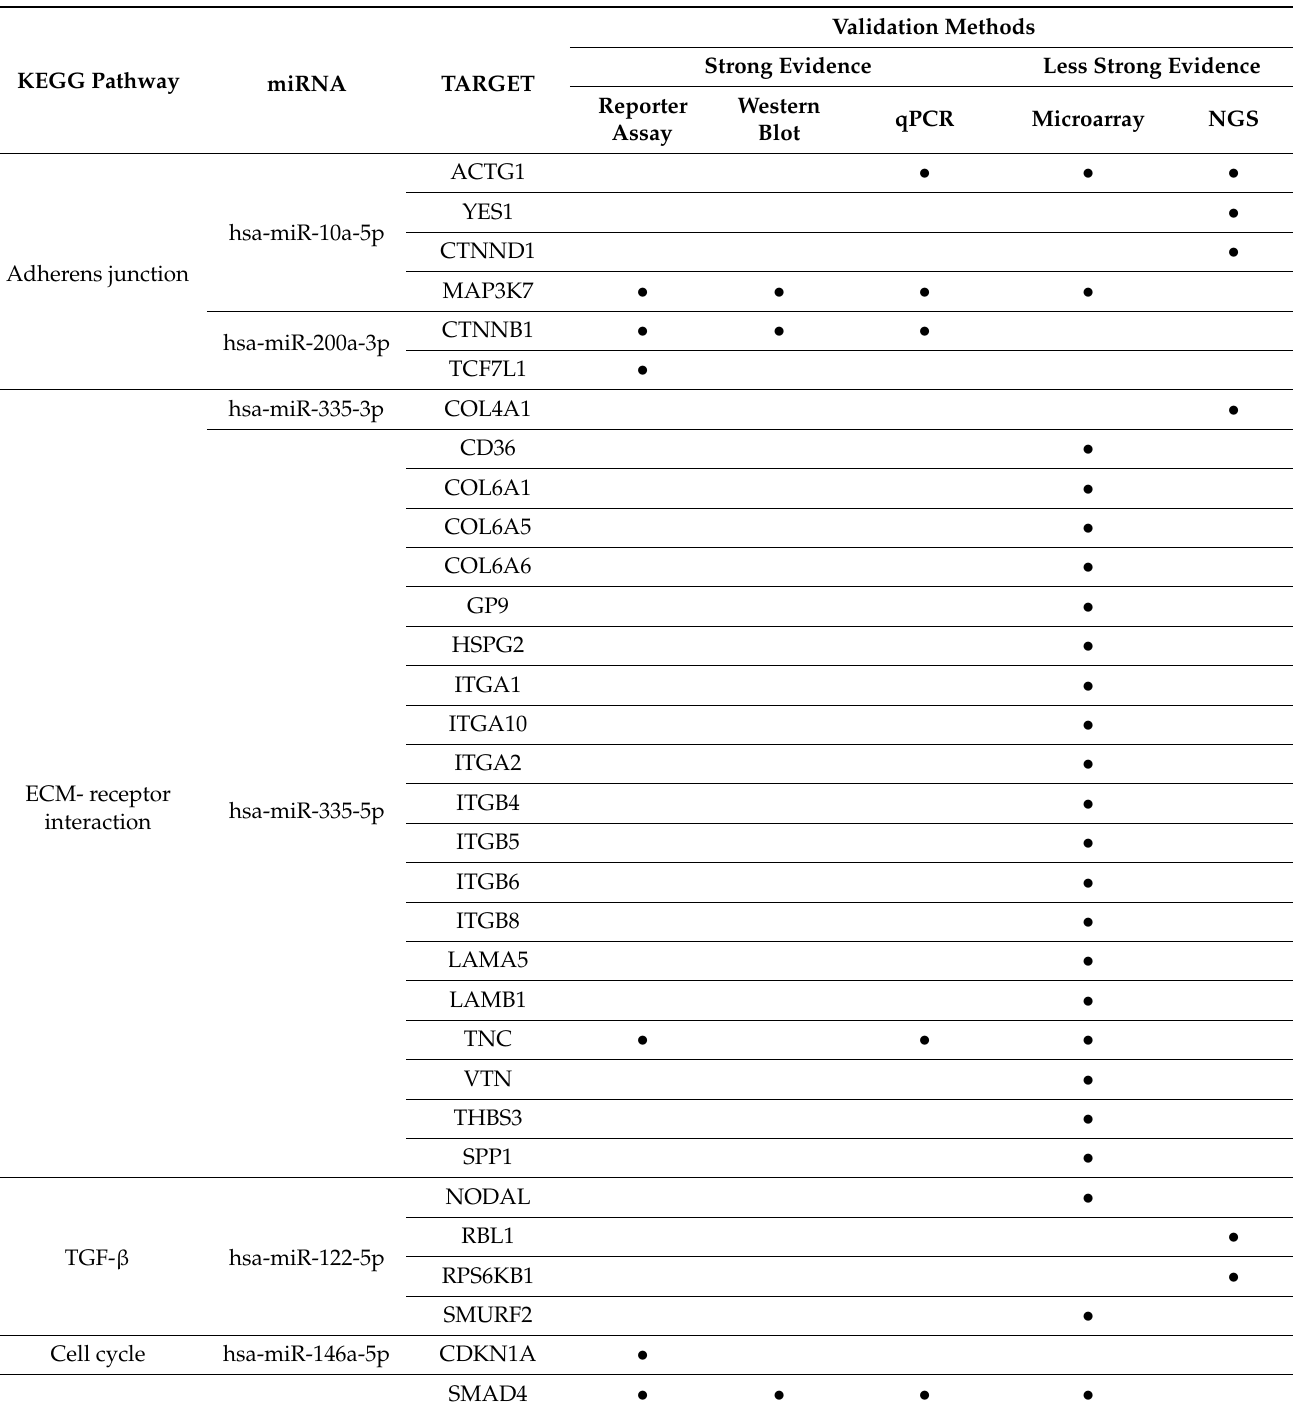
Table 1. Identification of protein targets by mirTarBase